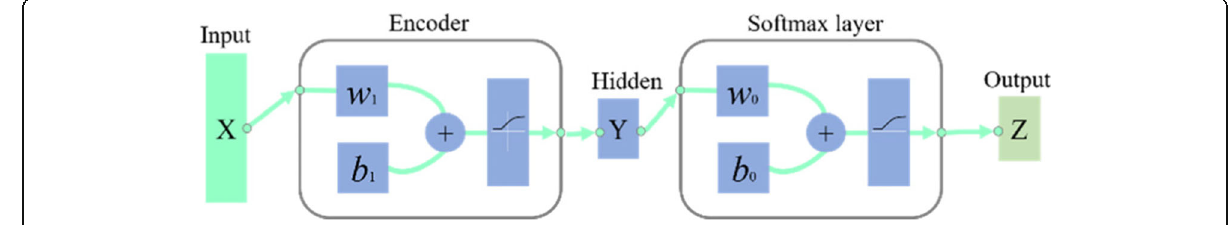
Fig. 3 Illustration of an auto-encoder learning for cancer